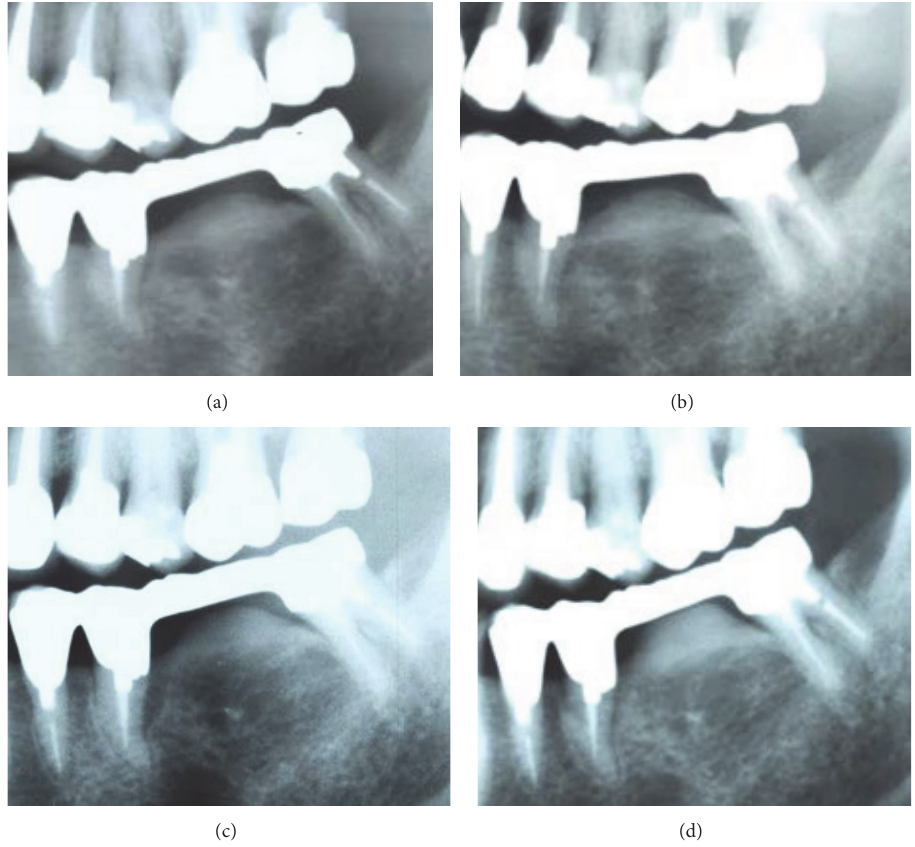
Figure 1: Panoramic radiographic images. (a) Image taken in October 2002 (before starting the oral bisphosphonate [BP]). (b) Image taken in February 2005 (before starting the oral BP). (c) Image taken in September 2008 (1 year and 4 months after starting the oral BP). (d) Image taken in September 2011 (5 years and 4 months after starting the oral BP). These images show chronological changes in the subpontic bone formation.